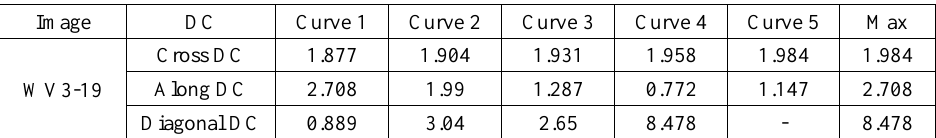
Table 4. The deviation coefficients of the projection trajectories in WV3-19. The deviation coefficients in the table have been multiplied by 10 4